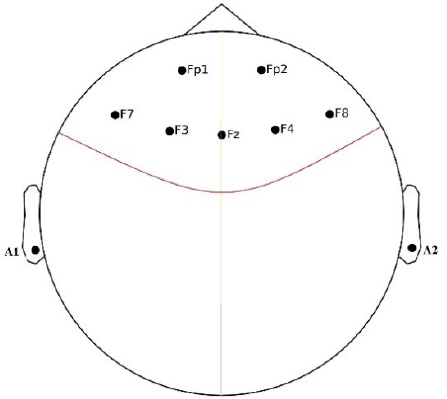
Figure 2. EEG electrodes’ placement on the scalp.